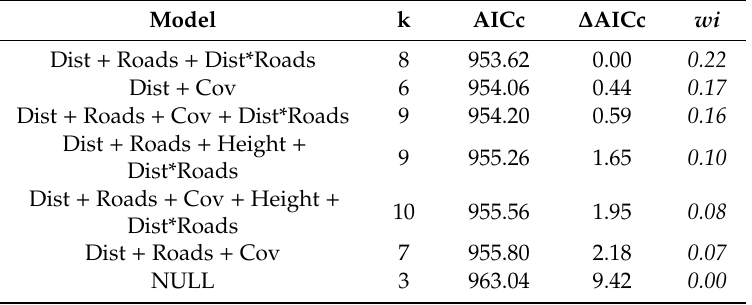
Table 1. First six models and NULL are shown and listed in decreasing order of importance according to guanaco spatial use intensity. The chosen models are in bold. k is the number of estimated parameters. Dist: minimum distance to the closest roads (m), cov: vegetation cover (%), height: vegetation height (cm), roads: paved road and unpaved road, and the interaction between distance and roads (Dist*Roads).